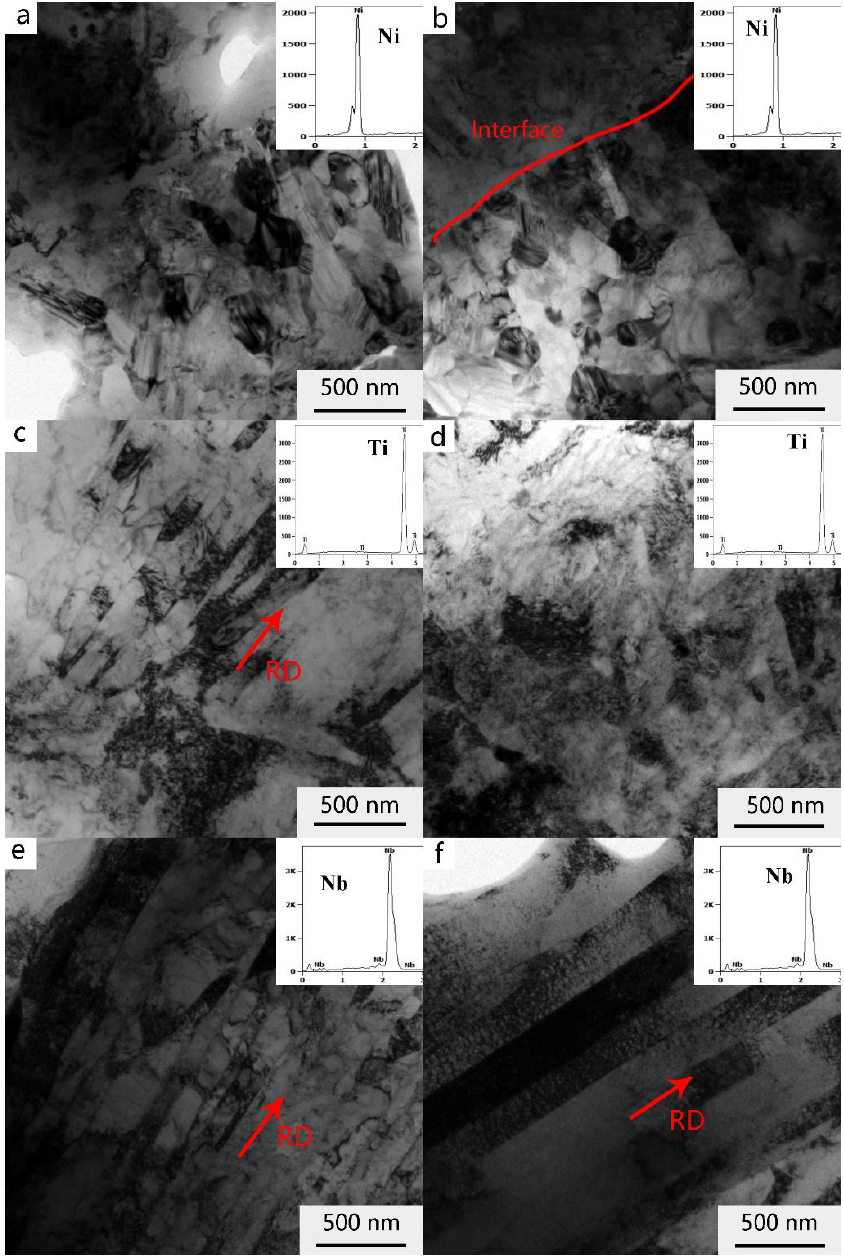
Figure 4. Transmission electron microscopy (TEM) micrographs of the Ni / Ti / Nb composite: ( a ) Ni layer after third pass, ( b ) Ni layer after the fifth pass, ( c ) Ti layer after the third pass, ( d ) Ti layer after the fifth, ( e ) Nb layer after the third pass, and ( f ) Nb layer after the fifth pass.